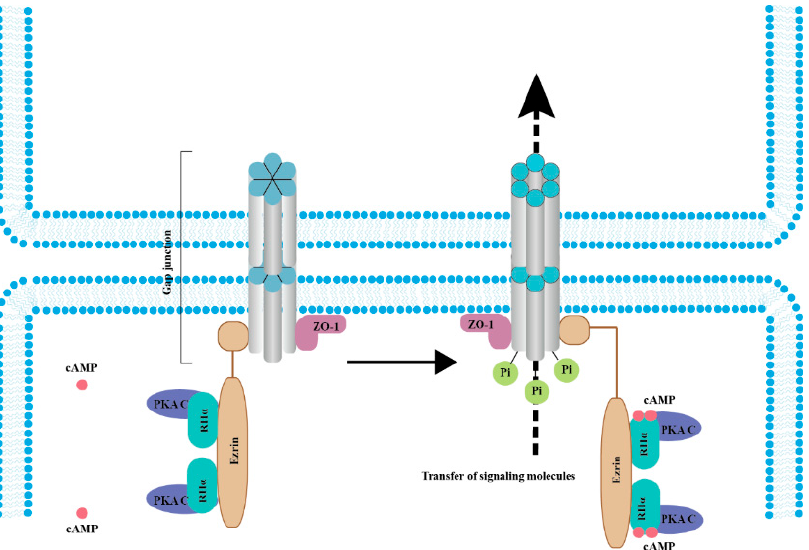
Figure 2. cAMP/PKA signaling mediates the phosphorylation of connexins (Cxs) to promote cancer cell migration and malignant transformation. In the resting state (left panel), the whole complex consists of Cx, ZO-1, Ezrin, and a PKA pool anchored by Cx-bound ezrin. When cAMP levels increase (right panel), PKA regulatory subunits bind to four cAMP molecules, resulting in activated PKA catalytic subunits, increased Cx phosphorylation, and gap junction-mediated intercellular coupling [26,53–55]. Abbreviations: RII α , PKA regulatory subunits and PKA C, PKA catalytic subunits.